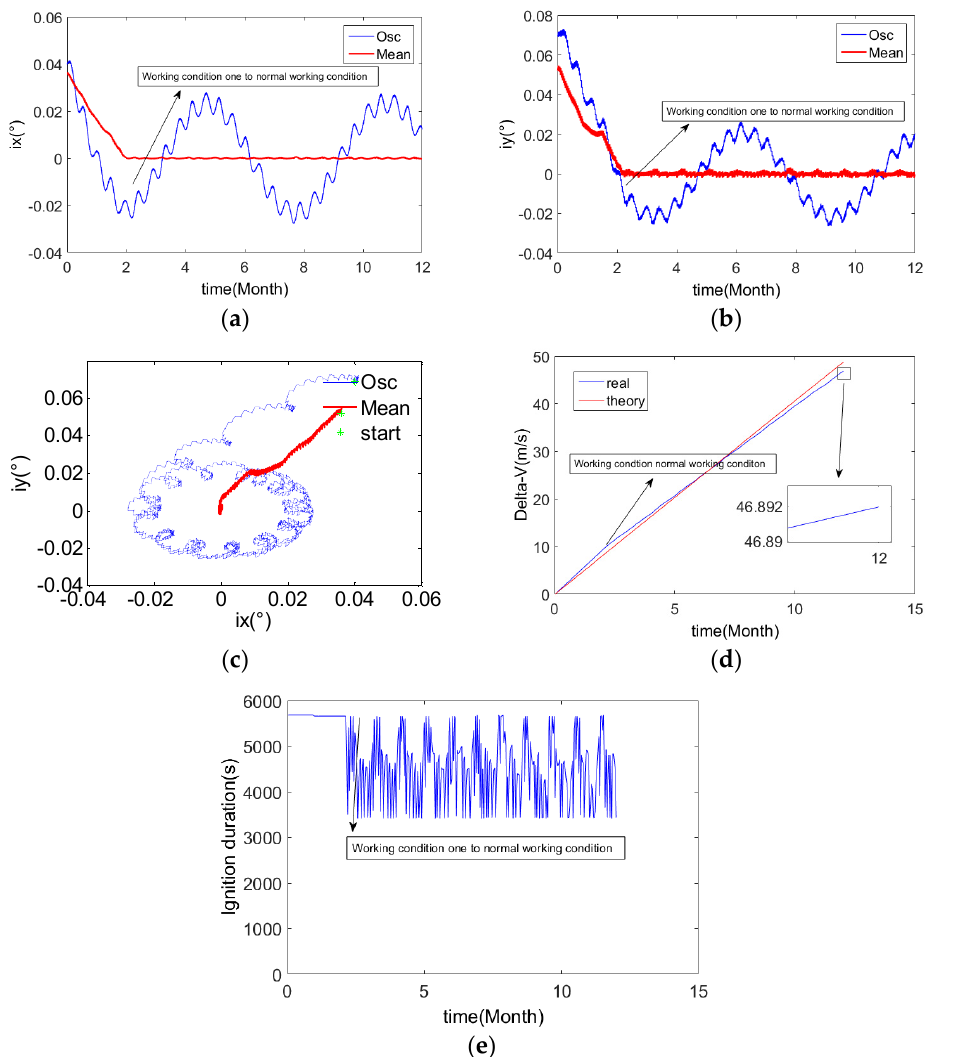
Figure 16. The results of example three. ( a ) Y-axis component of orbital inclination vector; ( b ) X-axis component of orbital inclination vector; ( c ) Orbital inclination vector; ( d ) Velocity increment for SK; ( e ) Duration of SK.